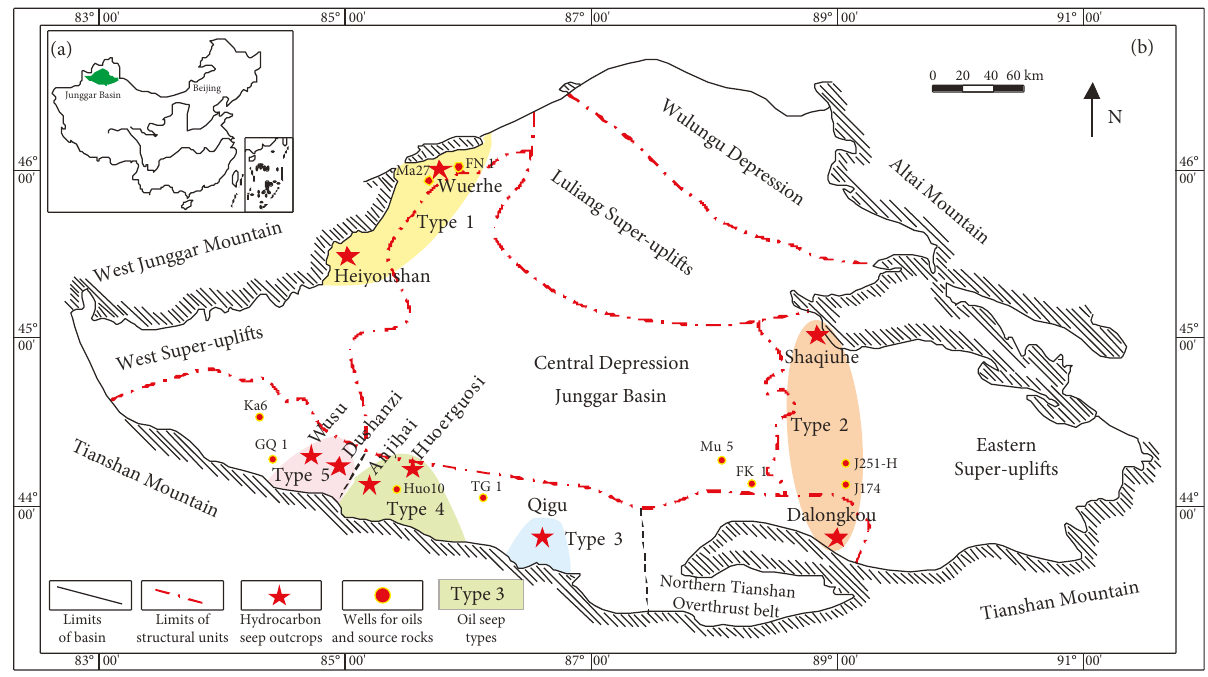
Figure 1: Location of the studied Junggar Basin in China (a) and the structural units and oil and gas seeps in the Junggar Basin, including the locations of the samples collected during this study